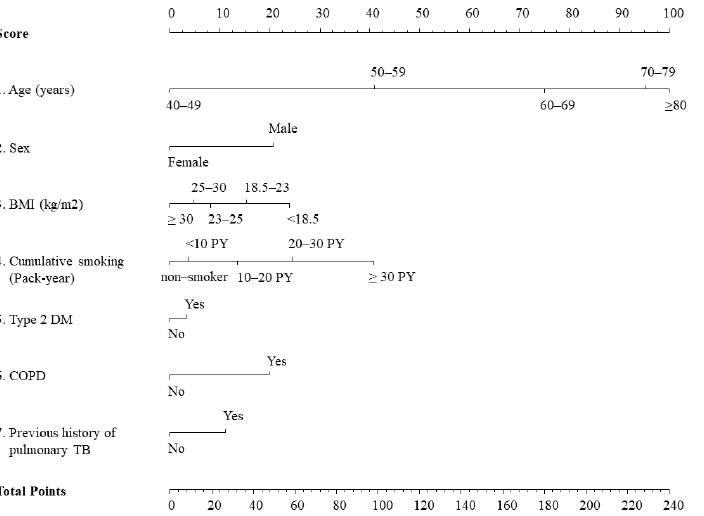
Figure 2. Nomogram for the 7-variable prediction model of lung cancer probability. BMI, body mass index; DM, diabetes mellitus; COPD, chronic obstructive pulmonary disease; TB, tuberculosis. index; DM, diabetes mellitus; COPD, chronic obstructive pulmonary disease; TB,